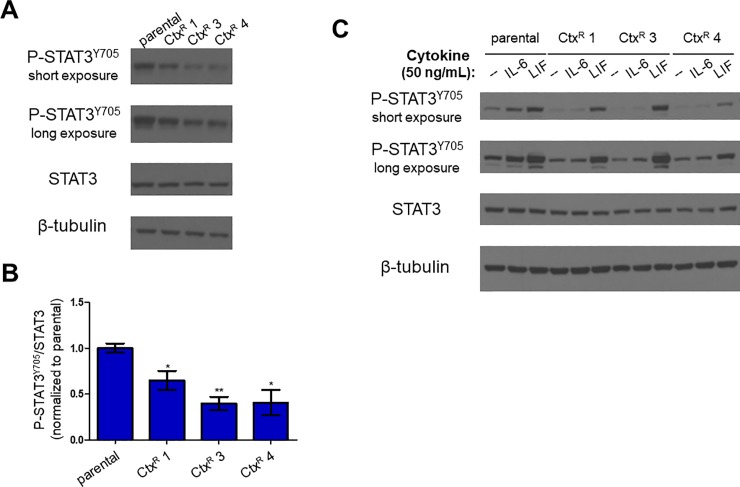
IL-6 signaling is impaired in PE/CA-PJ49 CtxR cells.A) PE/CA-PJ49 parental and CtxR cells were lysed in RIPA buffer and immunoblot was performed. Images shown are representative of three biological replicates. β-tubulin image shown is from the STAT3 blot. B) Densitometry was performed using ImageJ as described in Materials and Methods. Densitometry values for P-STAT3Y705 were normalized to those for total STAT3. Student’s t-test was used to determine whether differences in the P-STAT3Y705:STAT3 ratios in CtxR cells were statistically significant compared to parental cells. n = 3. *p<0.05; **p<0.01. C) PE/CA-PJ49 parental and CtxR cells were serum starved for 4 hours, then treated for 15 minutes with 50 ng/mL rhIL6 or rhLIF. Cells were lysed in RIPA buffer and immunoblot was performed. β-tubulin image shown is from the P-STAT3Y705 blot.